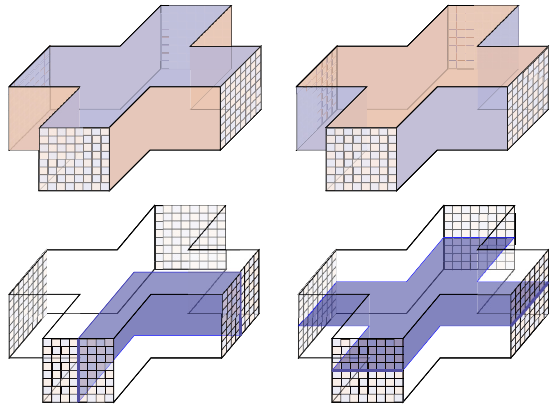
FIG. 8. Logical block templates for toric code spiders. On the left (right) we have the toric code spider for the ˆ x 4 ( ˆ z 4 ) operation. Lengths of the legs are exaggerated for illustration purposes. On the bottom row we depict two logical membranes; labeling the ports 1 to 4 clockwise from the left, we have example membranes X 3 X 4 ∈ S ( ˆ x 4 ) and X 1 X 2 X 3 X 4 ∈ S ( ˆ z 4 ) . The lengths of the legs of the spider are exaggerated for illustration